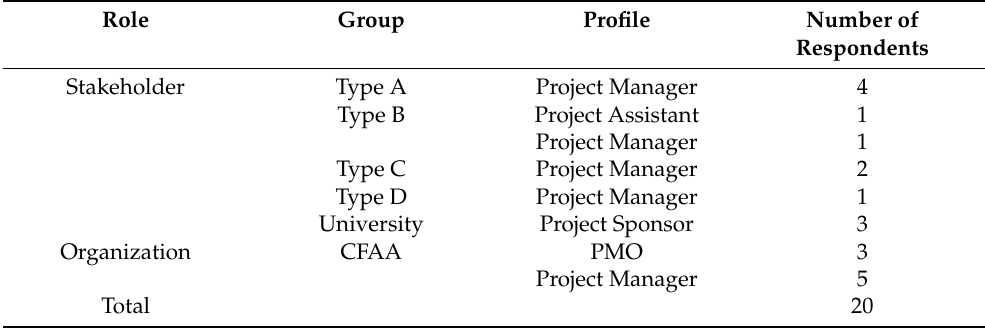
Table 7. Respondent